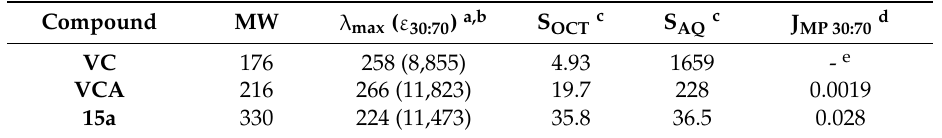
Table 2. Molar extinction coefficients in propylene glycol:water (PG:AQ), 30:70 ( ε 30:70 ), solubilities in 1-octanol (S OCT ) and in water (S AQ ) and maximum flux values through silicone membranes